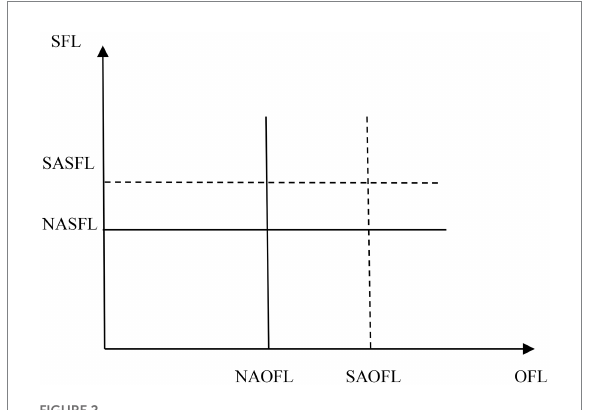
FIGURE 2 The comparison of state and national